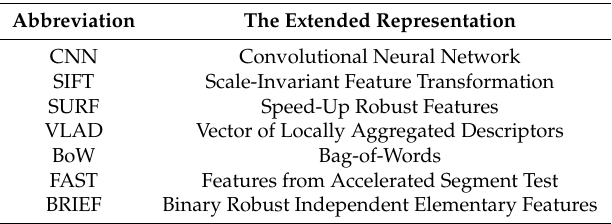
Table 1. Abbreviations used in this paper and their extended